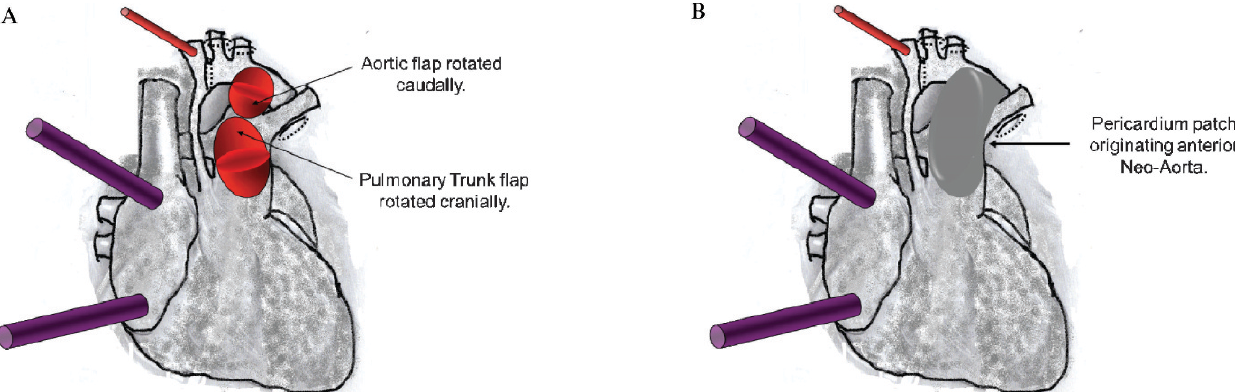
Figure 2 - A) The free edges of the semilunar flaps of the aorta and pulmonary trunk are rotated and sutured edge-to-edge originating the autologous posterior neo-aortic wall. B) A valved bovine pericardium patch is implanted from the anterior opening of the pulmonary trunk to the aortic arch and extends to the beginning of the descending aorta to give rise to the anterior wall of the neo-